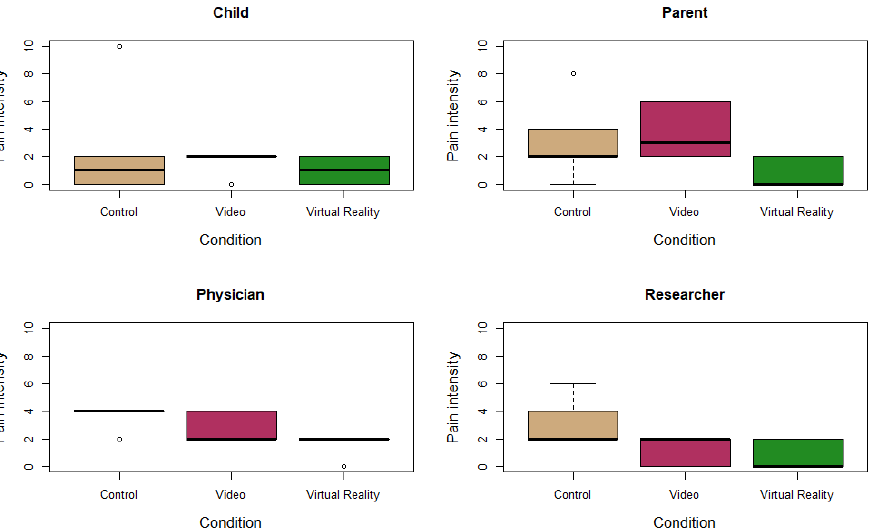
Figure 2. Pain ratings using the Wong–Baker Faces (WB-FACES) Scale for children, parents, physician and researcher after the three refill conditions: standard refill (brown), refill with video (pink) and refill with virtual reality (green).